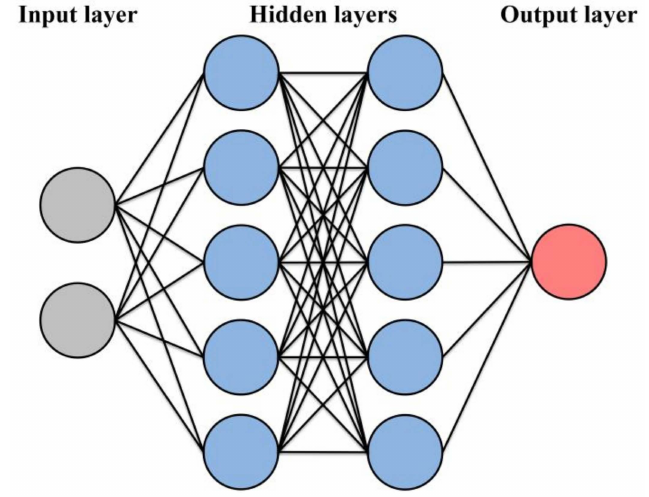
Figure 6. A schematic representation of an artificial neural network. The circles represent intercon- nected nodes (artificial